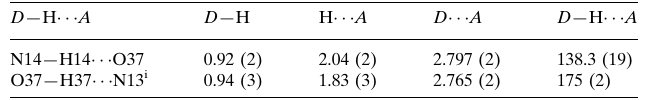
Data collection: SMART (Siemens, 1996); cell refinement: SAINT (Siemens, 1996); data reduction: SAINT ; program(s) used to solve structure: SHELXTL (Sheldrick, 2008 a ); program(s) used to refine structure: SHELXTL ; molecular graphics: SHELXTL ; software used to prepare material for publication: SHELXTL